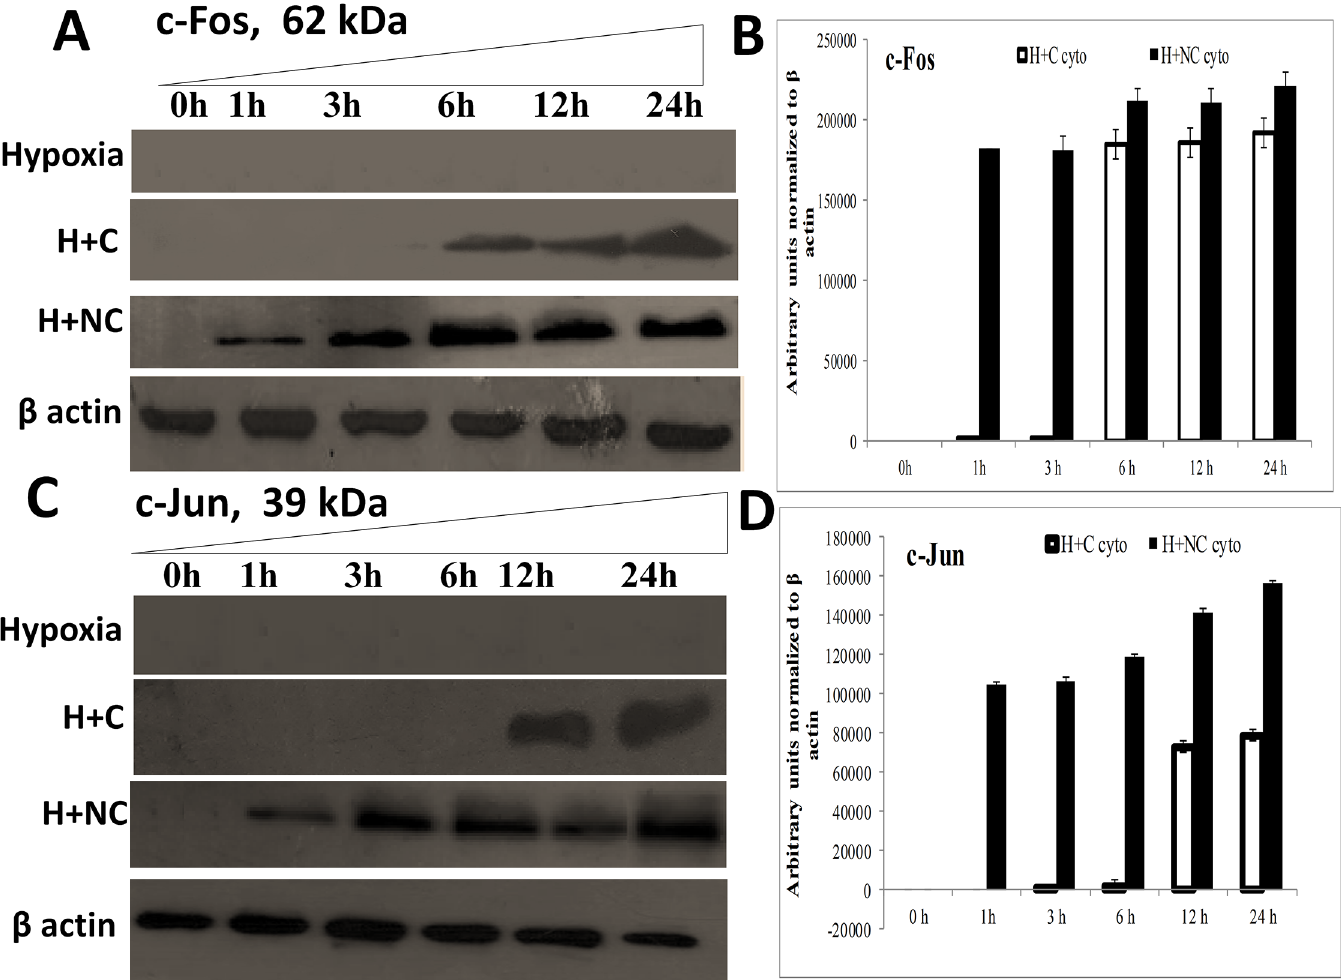
Fig 8. Nanocurcumin imparts cardio-protection in HVCM cells by activation of c-Jun/c-Fos: Hypoxia insult prevented c-Fos and c-Jun expression in HVCM cells upto 24 h of hypoxia and thus promoted translocation of p53 to mitochondria. Treatment of HVCM cells with nanocurcumin promoted c-Fos accumulation as early as 1 h of hypoxia and prevented p53 mediated cell-death whereas curcumin treated cells showed significant up-regulation of c-Fos and c-Jun by 6 – 12 h of treatment under hypoxia showing that nanocurcumin is frequently available to the cells compared to curcumin. Nanocurcumin treated cells showed higher expression of negative regulators of p53 accumulation, i.e. c-Jun and c-Fos in HVCM cells under hypoxia, depicting that improved bio- availability and stability of nanocurcumin prevents hypoxia induced damage in cardiomyocytes.